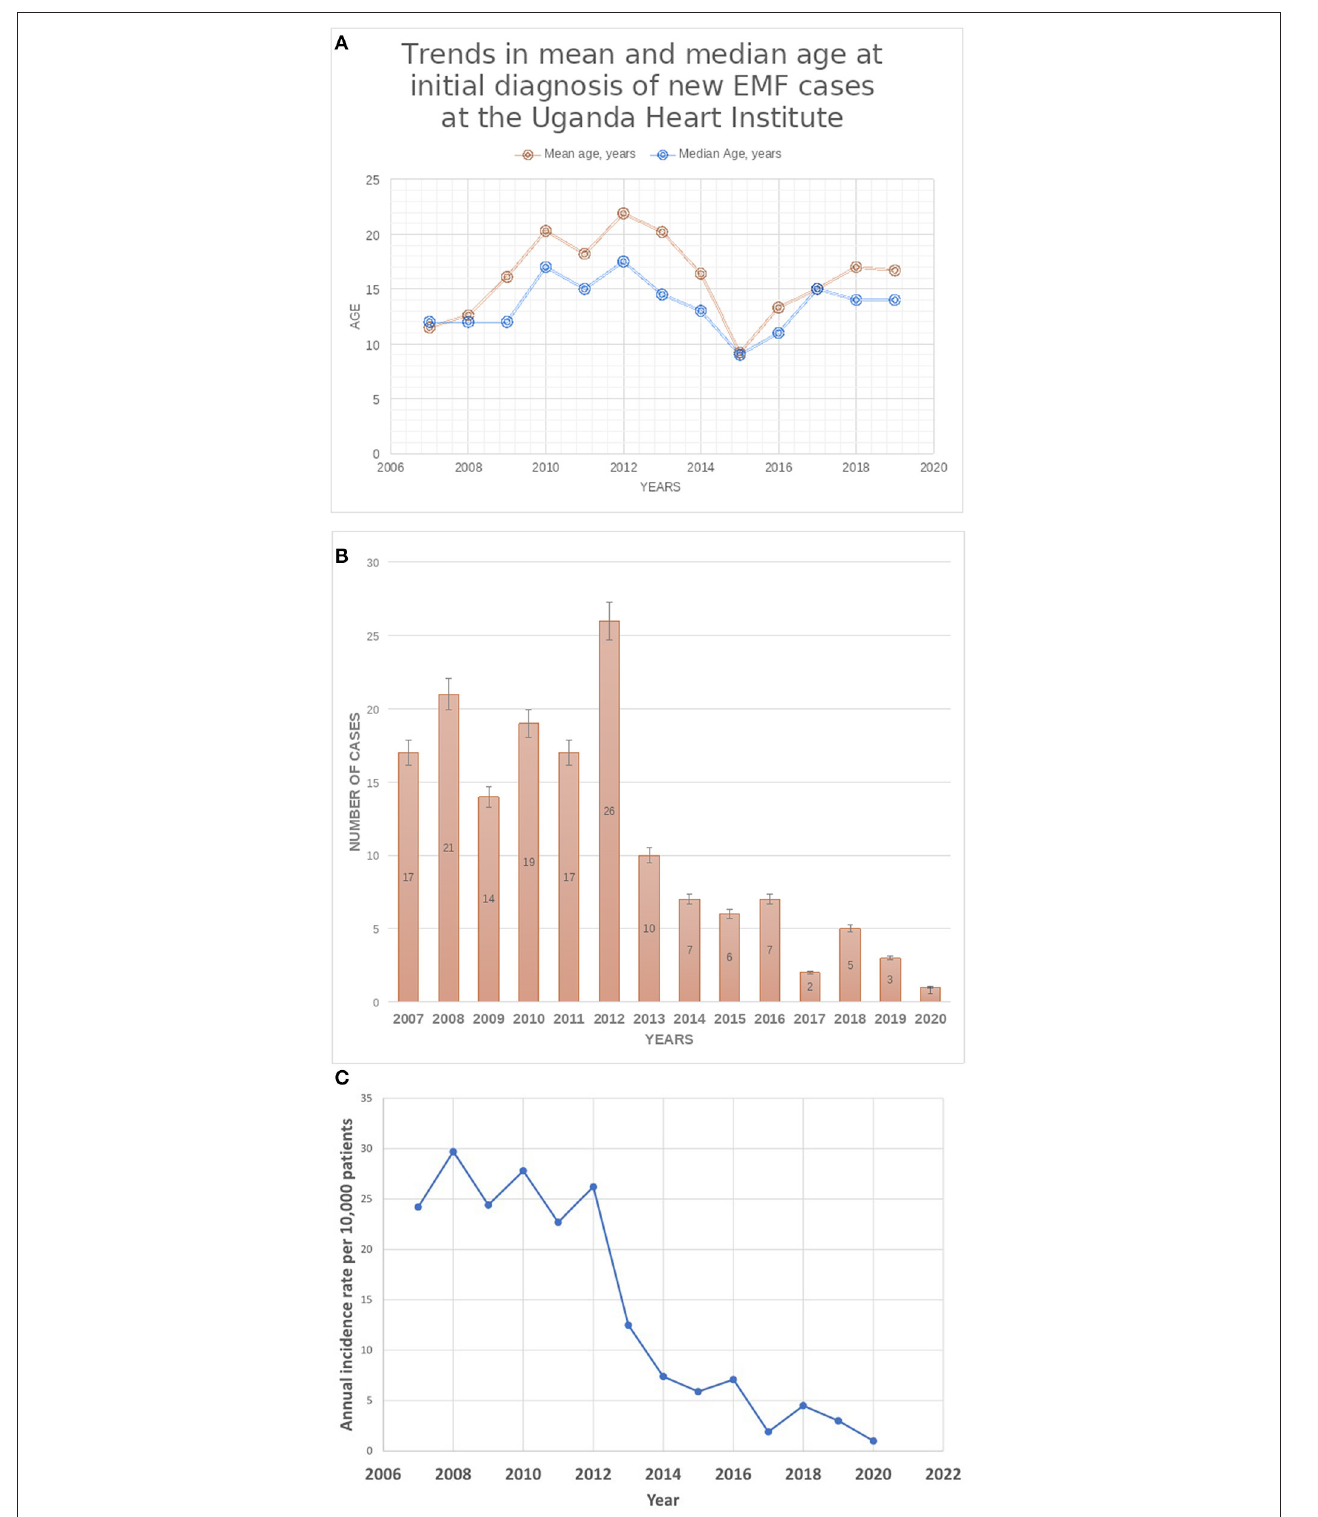
FIGURE 2 | (A) Trends in mean and median age at initial diagnosis of new EMF cases at UHI. (B) Trends in Total Number of New cases of EMF diagnosed at the Uganda Heart Institute. (C) Trends in the annual Incidence of rates of newly diagnosed EMF at the Uganda Heart Institute. Note the dramatic decline in the incidence rates after the year